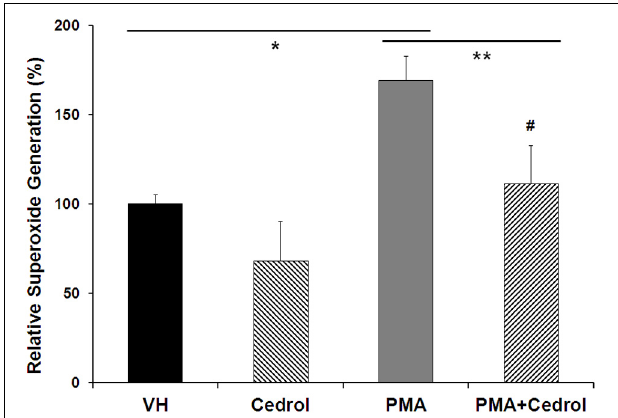
FIGURE 5 | Cedrol suppressed intracellular ROS generation in K562 cells. K562 cells were treated with either VH or cedrol (200 µ M) for 18 h and then exposed to 0.3 µ M phorbol 12-myristate 13-acetate (PMA) for 5 min. DCFH-DA (10 mM) assay was performed, and the fluorescence of product DCFHA was measured by flow cytometry. Values expressed are means ± SD of percent relative fluorescence units for three independent experiments. * P vs. VH; ** P vs. VH + PMA; #non-significant vs. VH (vehicle control).